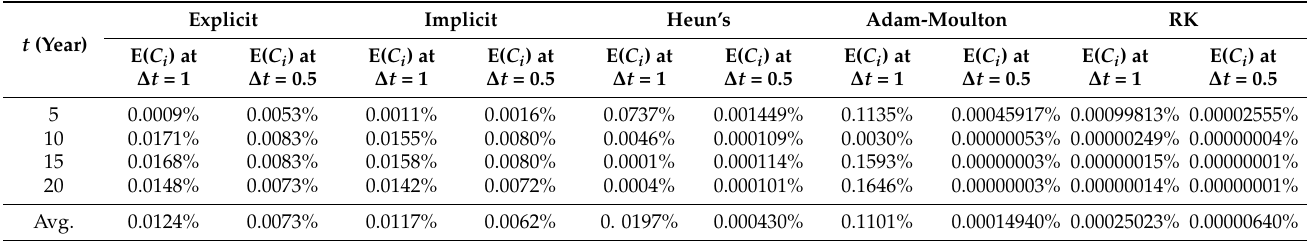
Table 4. The effect of changing ∆ t on the results of C i .